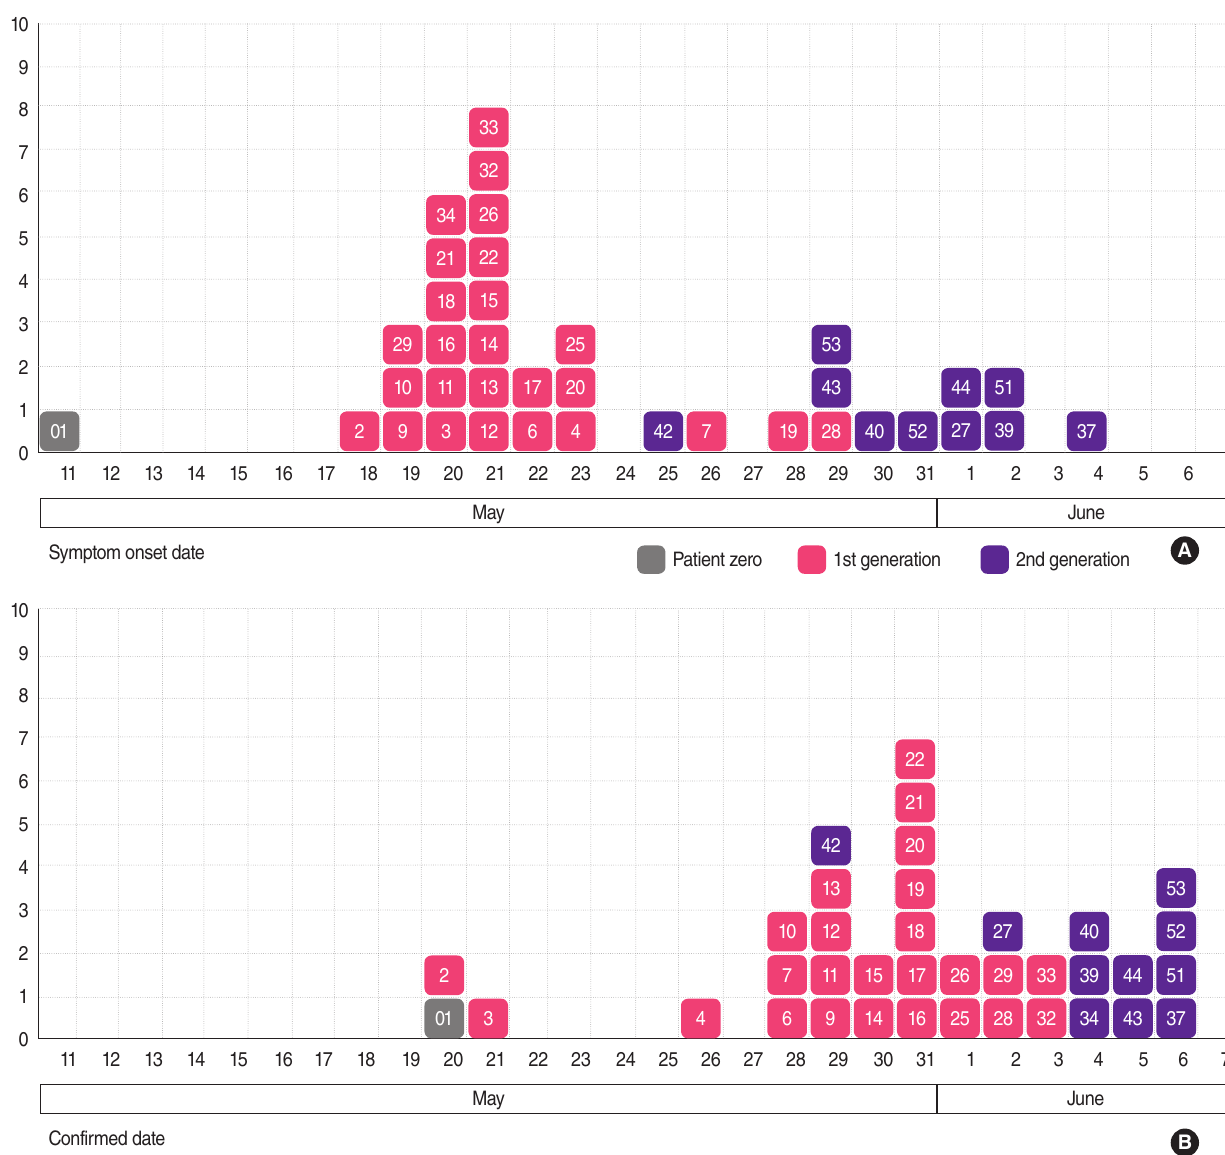
Figure 1. Epidemic curves of MERS outbreak at Pyeongtaek St. Mary’s Hospital, Korea. (A) Curve by symptom onset date, (B) curve by con­ firmed